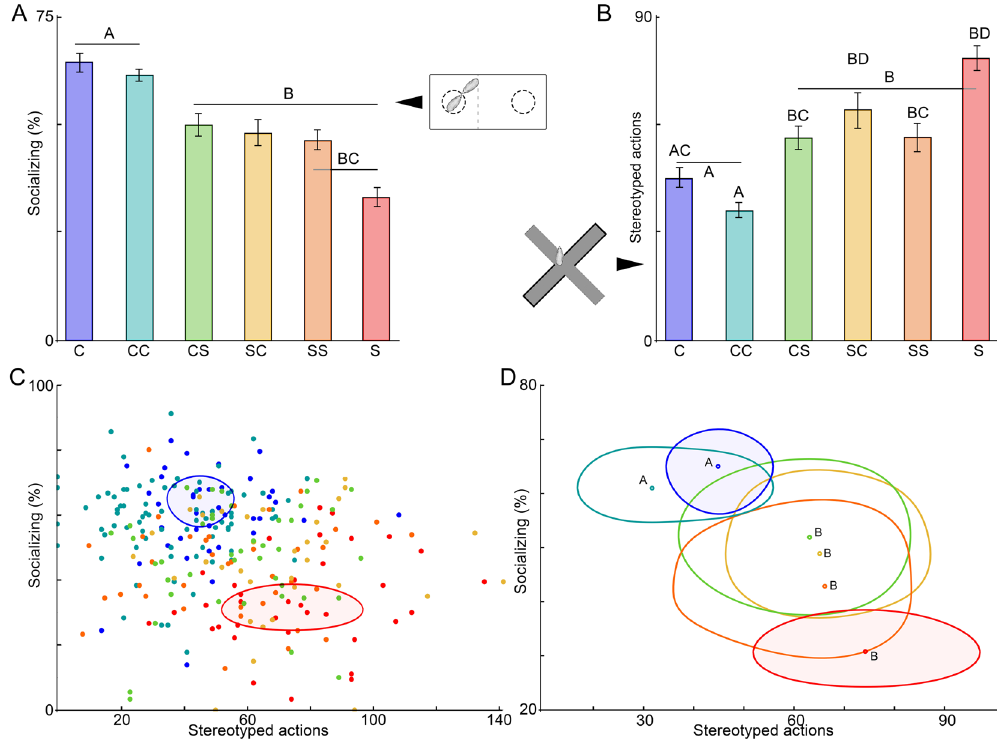
Figure 5. DCCD induces adult behavioral abnormalities. Mice exposed to DCCD exhibit a significant decrease in % time spent exploring a same-sex, same-age unfamiliar mouse (median + / − standard error) ( A ). DCCD offspring are hyperactive when exploring a novel elevated plus maze (median + / − standard error) ( B ). Note that SC offspring exhibit significantly greater separation from C and CC than do CS offspring. Individual socializing and hyperactivity scores plotted against each other reveal phenotypic separation by condition ( C ). Contours describing the 50% inclusion level for S and C are shaded. Contours for all groups ( D ) illustrate the significant separation of DCCD phenotypes from C phenotype. Groups with significant differences indicated by letters on bars; colors are consistent for groups across all plots.